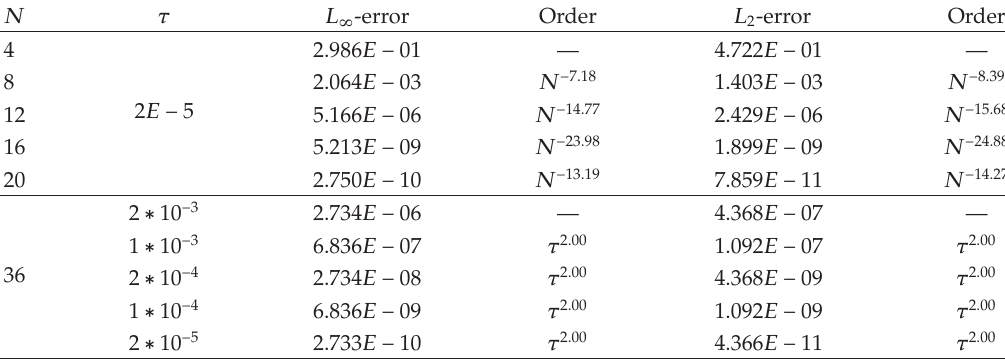
Table 4: Convergence rates at t (cid:7) 1 with μ (cid:7) 0 . 1, α (cid:7) 1, β (cid:7) 0 . 01, γ (cid:7) 3, and n (cid:7) 2.